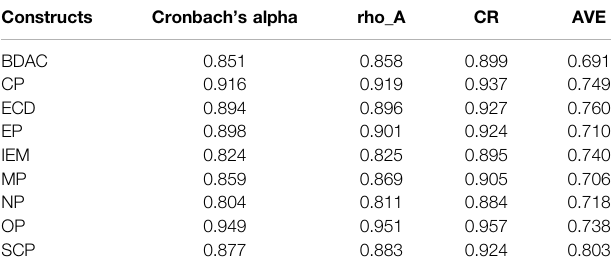
TABLE 2 | Reliability and validity